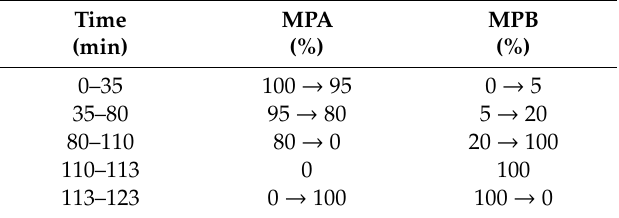
Table 4. Details of the HPLC gradient method used for PRPE